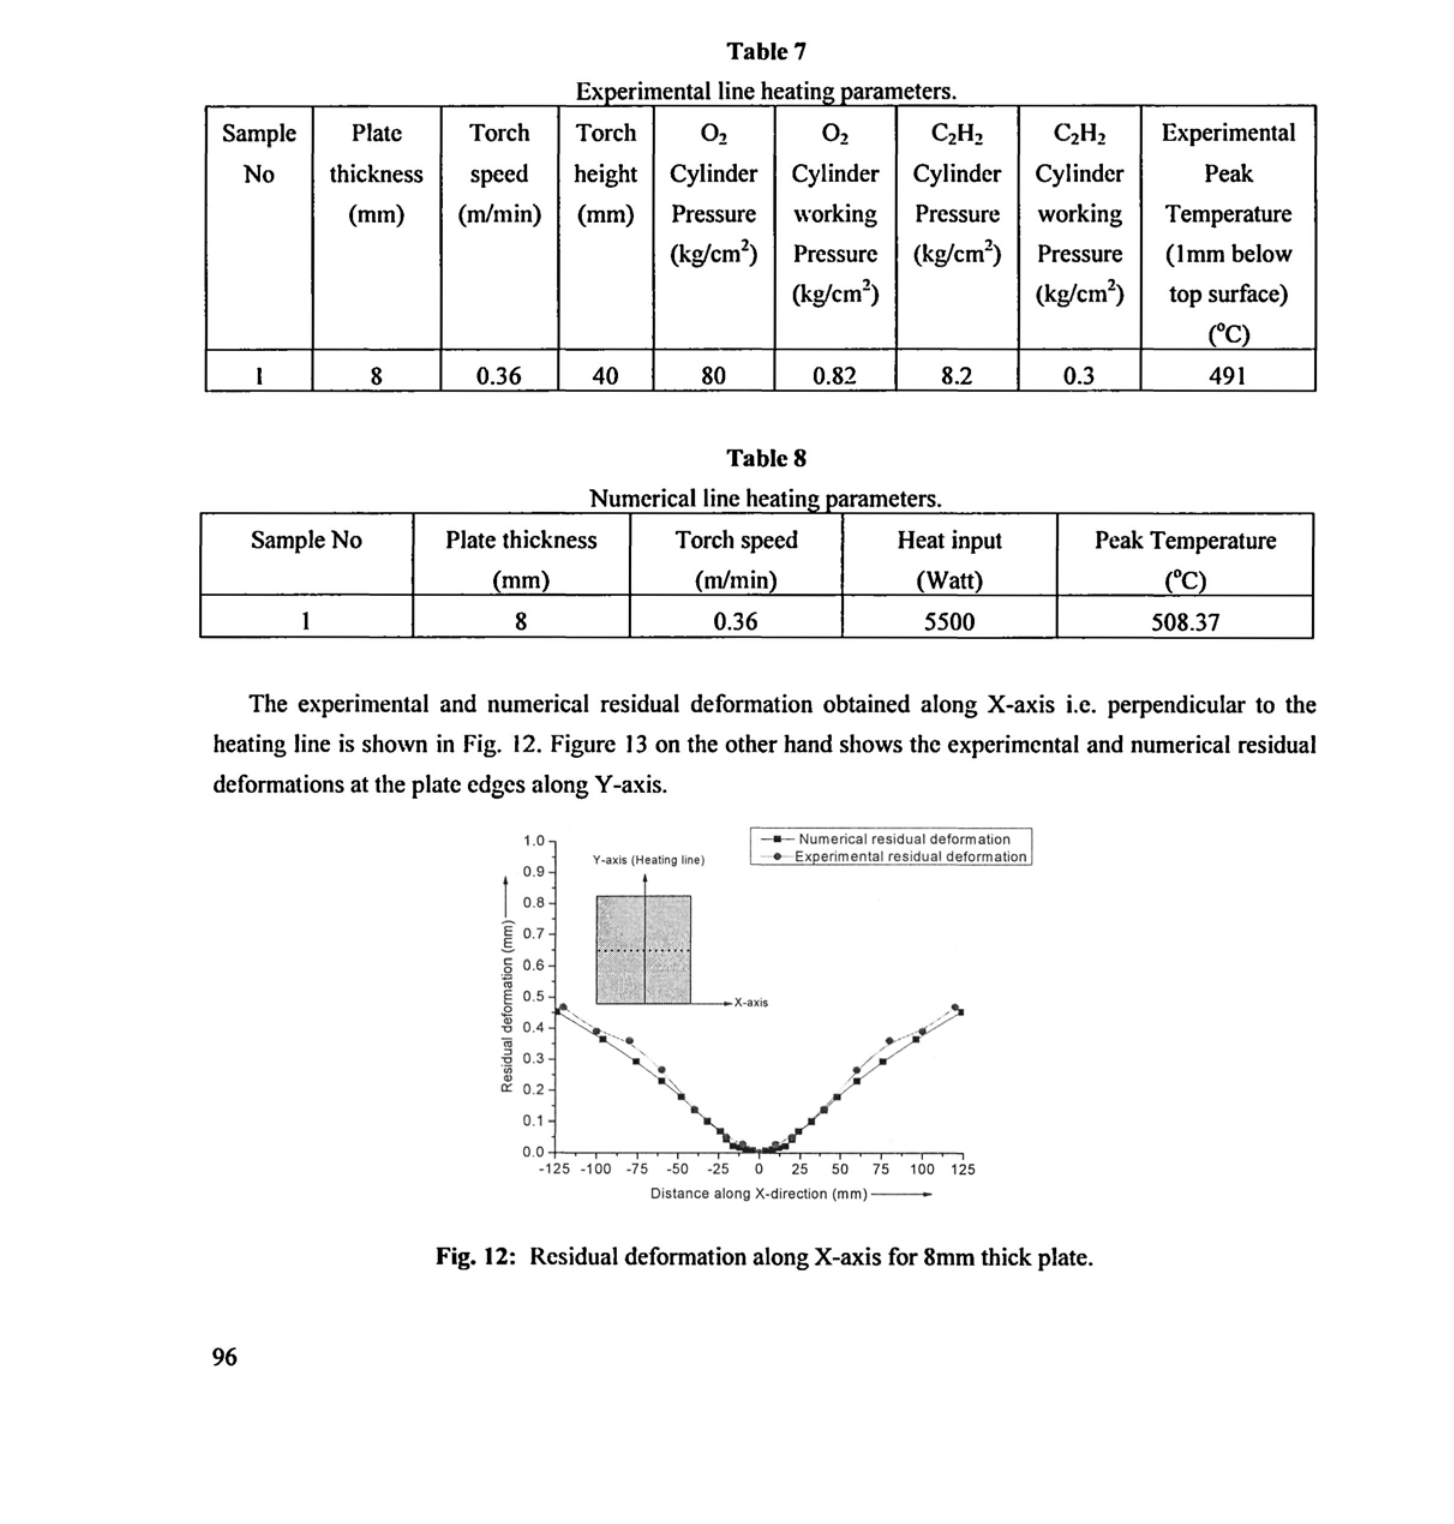
Experimental line heating parameters.